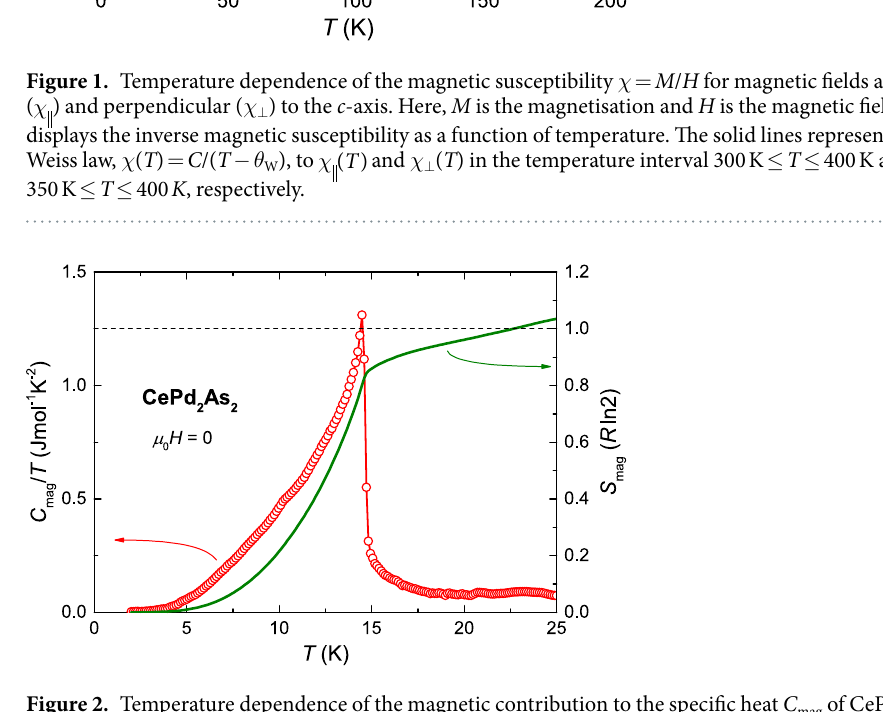
Figure 2. Temperature dependence of the magnetic contribution to the specific heat C mag of CePd 2 As 2 , plotted as C mag ( T )/ T (left axis). C mag was estimated by subtracting the specific heat of the non-magnetic reference compound LaPd 2 As 2 from that of CePd 2 As 2 . The calculated magnetic entropy S mag ( T ) is displayed in the unit of R ln2 (right